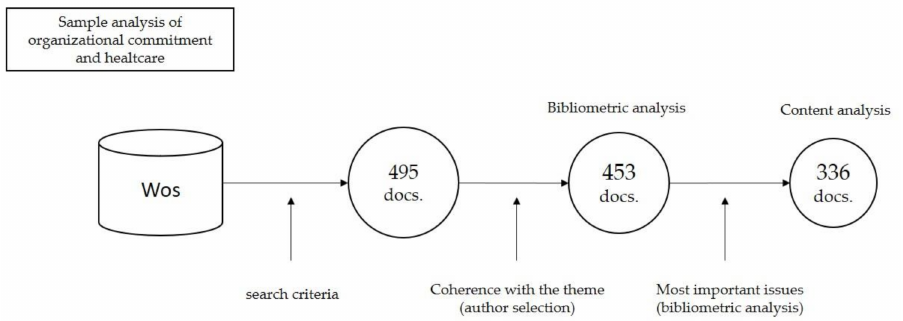
Figure 1. Sample analysis of organizational commitment and healthcare. Source: Prepared by the authors. Wos (Web of Science); Docs.